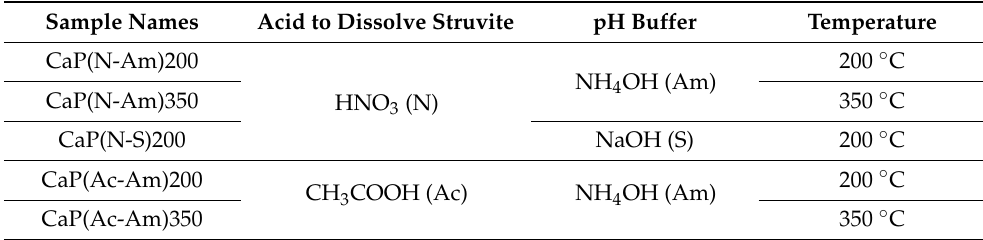
Table 1. The five samples synthesised via a hydrothermal synthesis process at 200 and 350 ◦ C, with pH 11 of calcium nitrate tetrahydrate [Ca (NO 3 ) 2 · 4H 2 O] solution and pH 6 of struvite solution, along with their respective codes, are highlighted below. The pH of both solutions was adjusted using